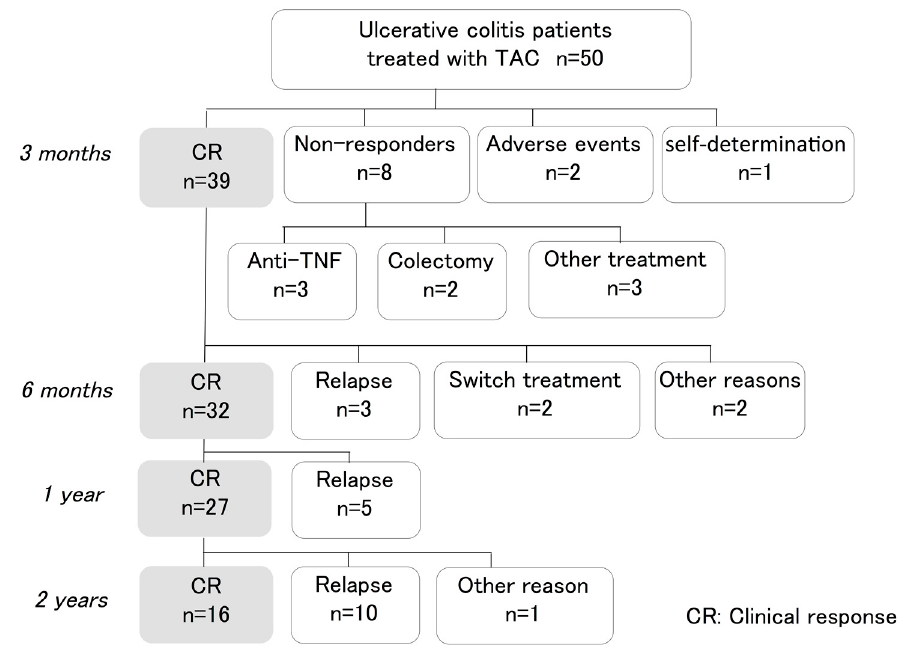
Figure 1. Flowchart of treatment outcomes. Clinical outcomes were assessed at 3, 6, 12, 24, and 36 months after initiating tacrolimus (TAC).